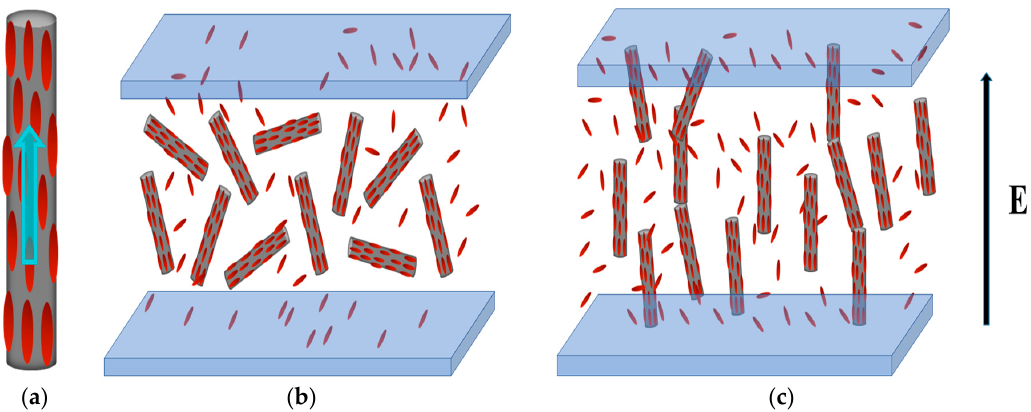
Figure 9. ( a ) Psudonematic domain (PND) formation around a CNT in an LC matrix; ( b ) PND in the isotropic phase; and ( c ) PND alignment along the electric field.